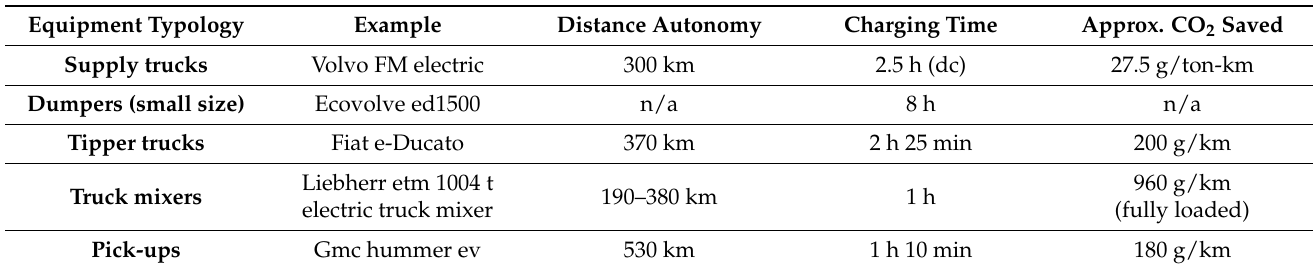
Table 3. Construction vehicle key data for fuel-free